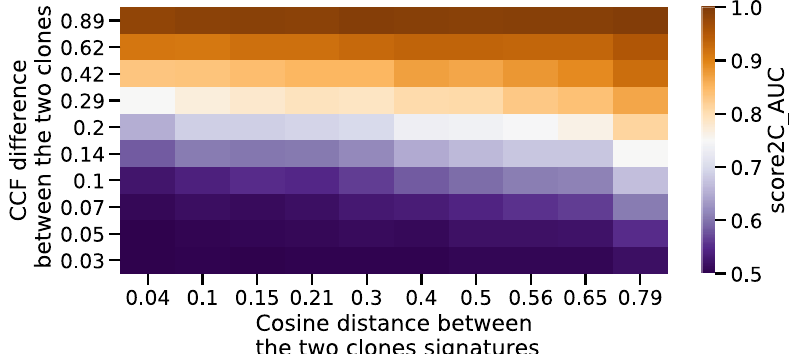
Fig. 4 Accuracy of the number of clones estimated by CloneSig. To illustrate the factors that impact the validity of the subclonal reconstruction performed by CloneSig, we have simulated samples with two clones, varying both the difference in the cancer cell fraction (CCF) between the two clones (vertical axis) and the cosine distance between their mutational pro fi les (horizontal axis). The accuracy denotes the proportion of runs where CloneSig